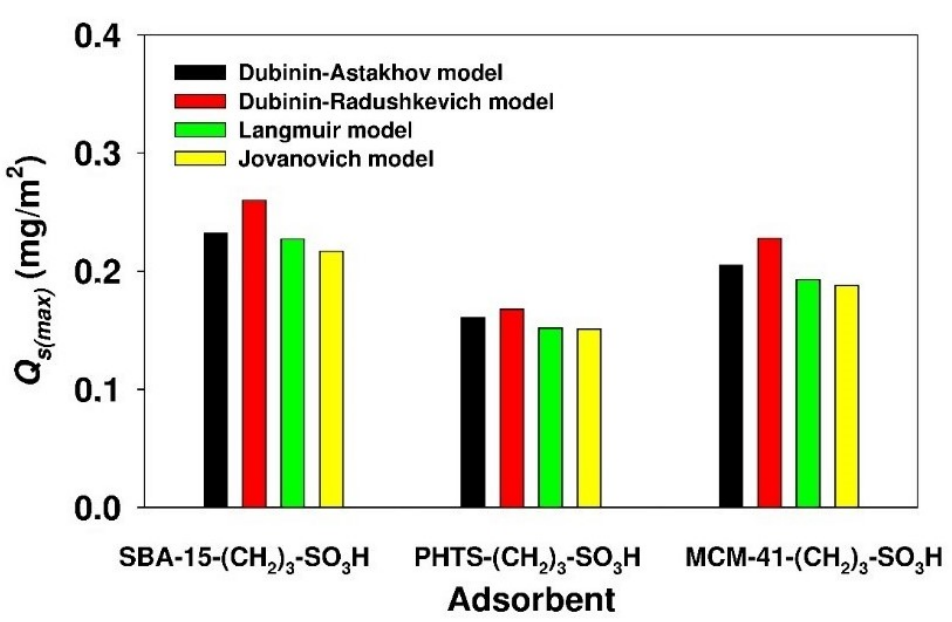
Figure 7. Surface area-normalized adsorption capacity of propyl-sulfonic acid-modified mesoporous adsorbents.